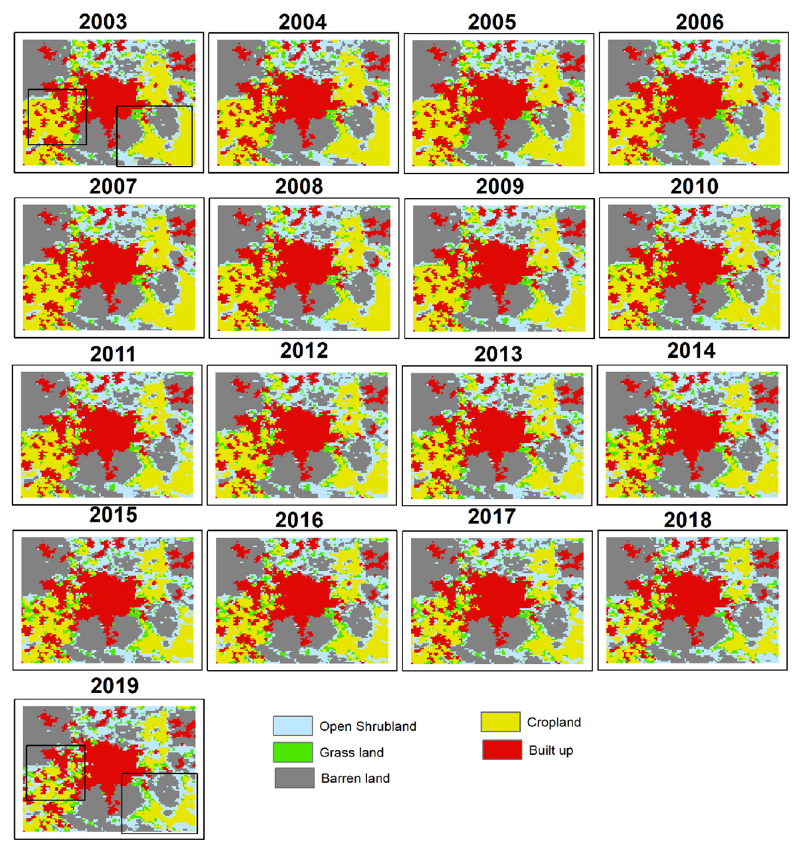
Figure A1. Annual LULC maps of the Isfahan metropolitan area from 2003 to 2019 extracted from MCD12Q1.